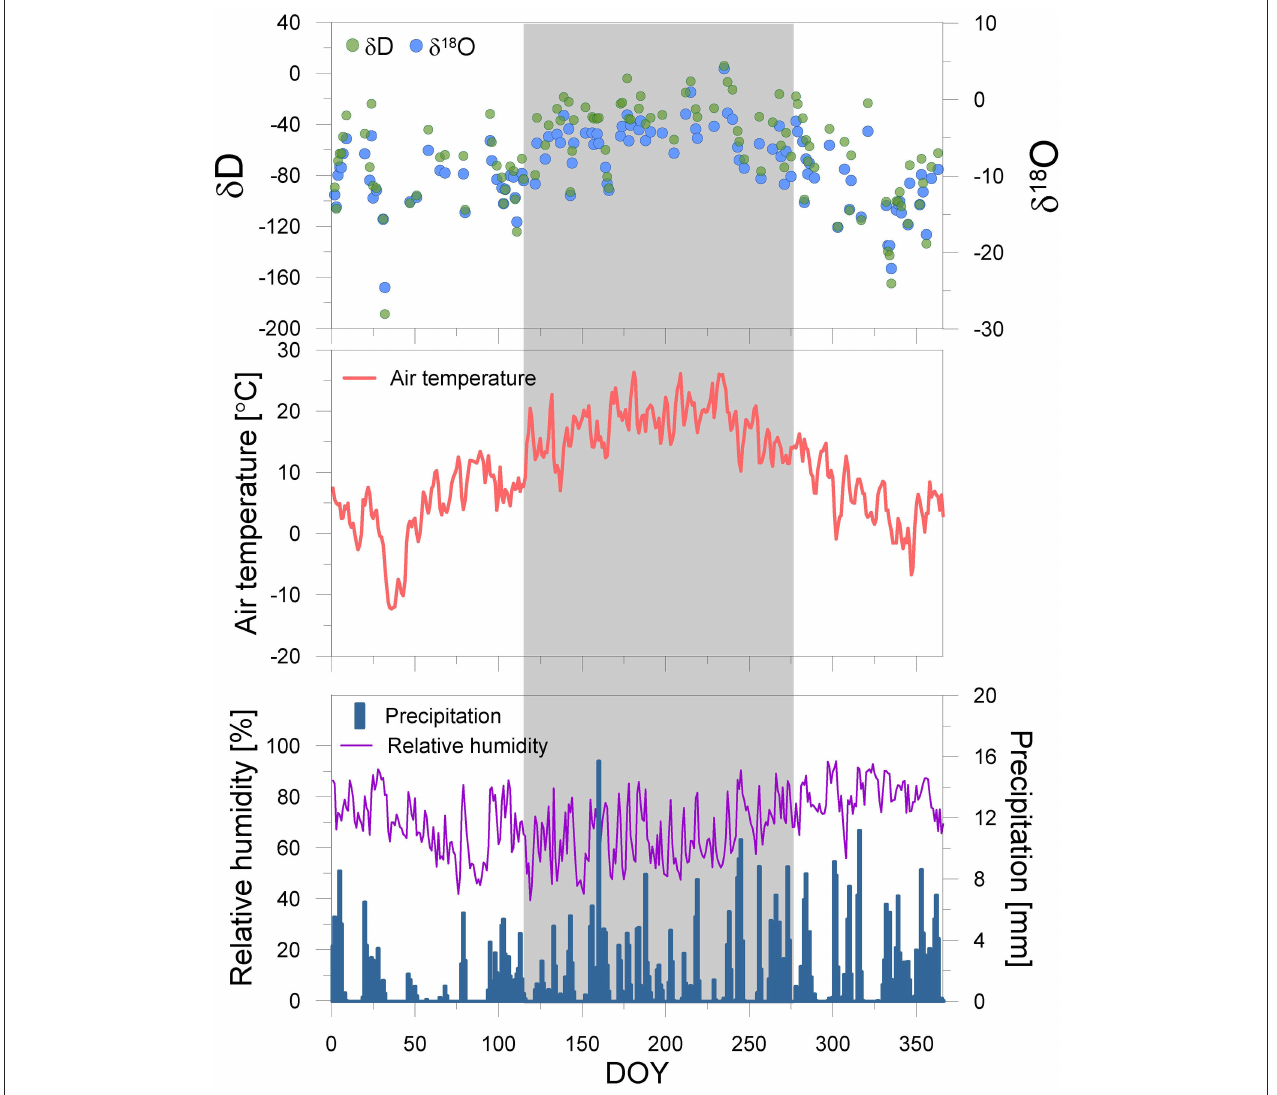
FIGURE 2 | Seasonal course of the meteorological parameters temperature, precipitation and relative humidity, and the water stable isotopes of precipitation at the sampling site in 2012. The date is reported in Day of Year (DOY). The deep blue bars, purple- and red line, green- and light blue circles represent the precipitation [mm], relative humidity [%], temperature [ ◦ C], and δ D and δ 18 O of precipitation [ h ], respectively. The gray shaded area denotes the sample period for